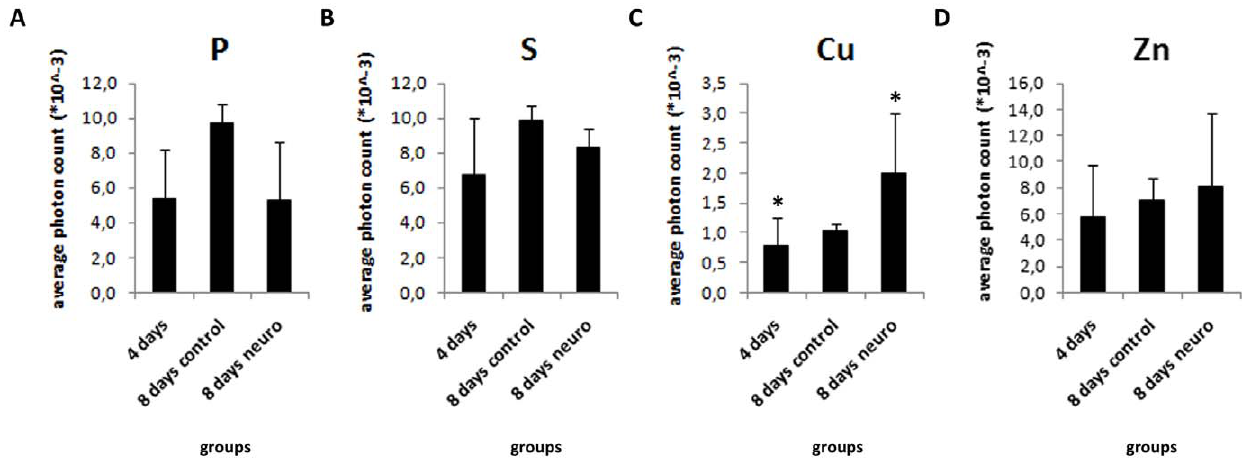
Figure 5. Murine embryoid bodies show similar levels of P, S, Cu and Zn at different stages of differentiation. Measure of elemental content normalized per irradiated area, A) P; B) S; C) Cu; D) Zn, *p ,